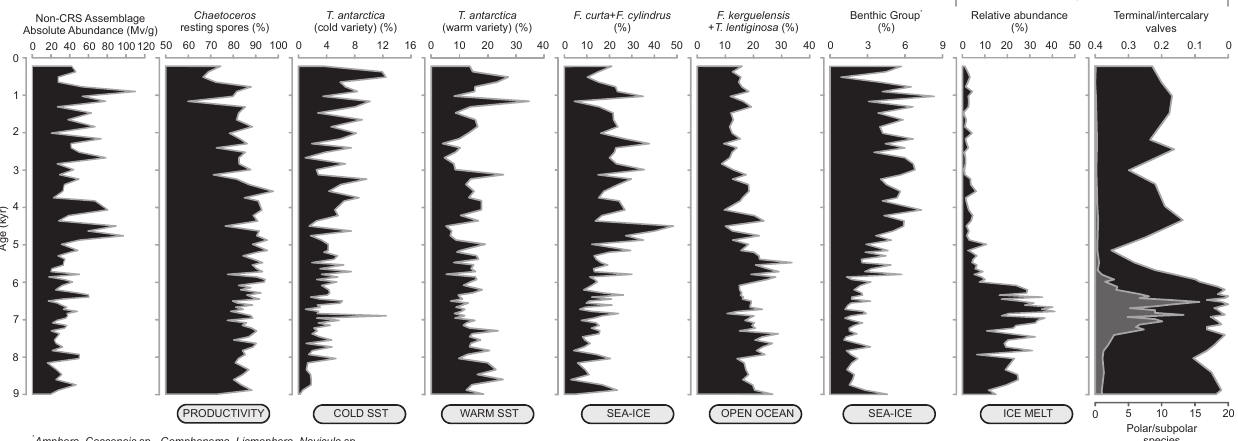
Fig. 6. Chaetoceros -free diatom relative abundance (%) of selected environmental indicator species from core JPC-10. On the right panel, the grey curve indicates the ratio between polar and subpolar E. antarctica species, while the terminal and intercalary valves ratio is illustrated in black.